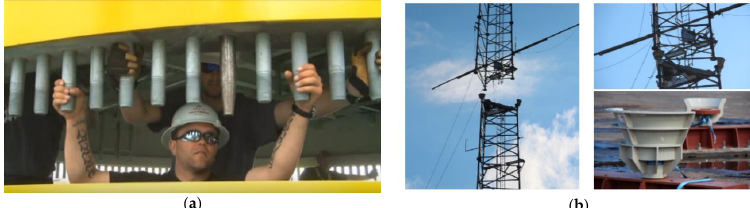
Figure 1. Examples of mechanical guidance systems: ( a ) Current use of guide pins; ( b ) Guide cones for human-free met mast installation [4].